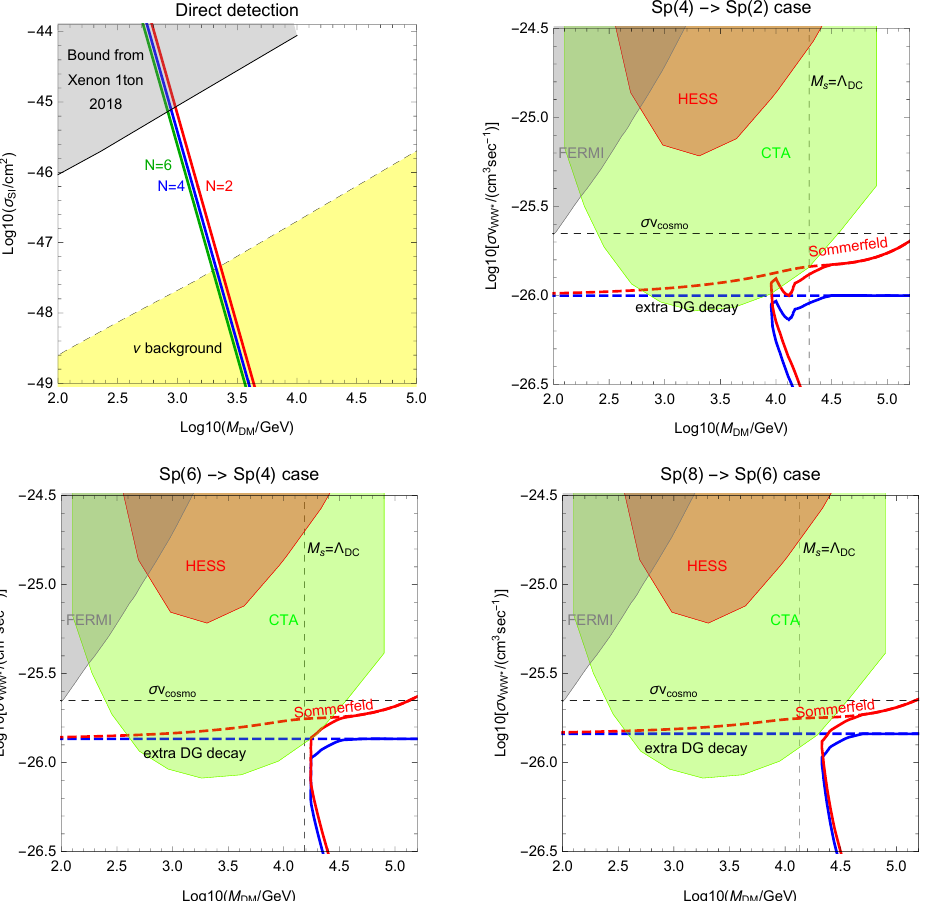
Figure 3 . The (cid:12)rst plot: predicted cross section for DM direct detection under the assumption that W reproduce the full DM abundance of the Universe and some extra new physics gives fast glueball decays. Other plots: predicted annihilations cross sections for indirect detection under the assumption that W reproduce the full DM abundance of the Universe, for di(cid:11)erent values of N . The solid lines are obtained taking into account the dilution due to long-lived glueballs; the dashed lines are obtained assuming that some extra new physics gives fast glueball decays. The red lines take into account the Sommerfeld enhancement in indirect detection cross section. The vertical dashed line is the boundary between the perturbative and condensed phase, which is estimated as the scale at which M s (cid:25) (cid:3) DC